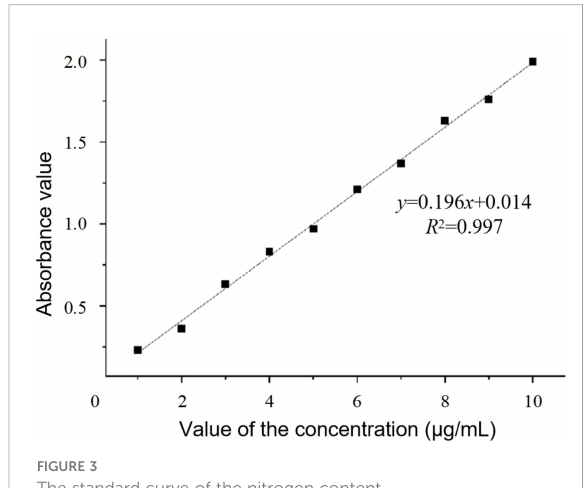
FIGURE 3 The standard curve of the nitrogen